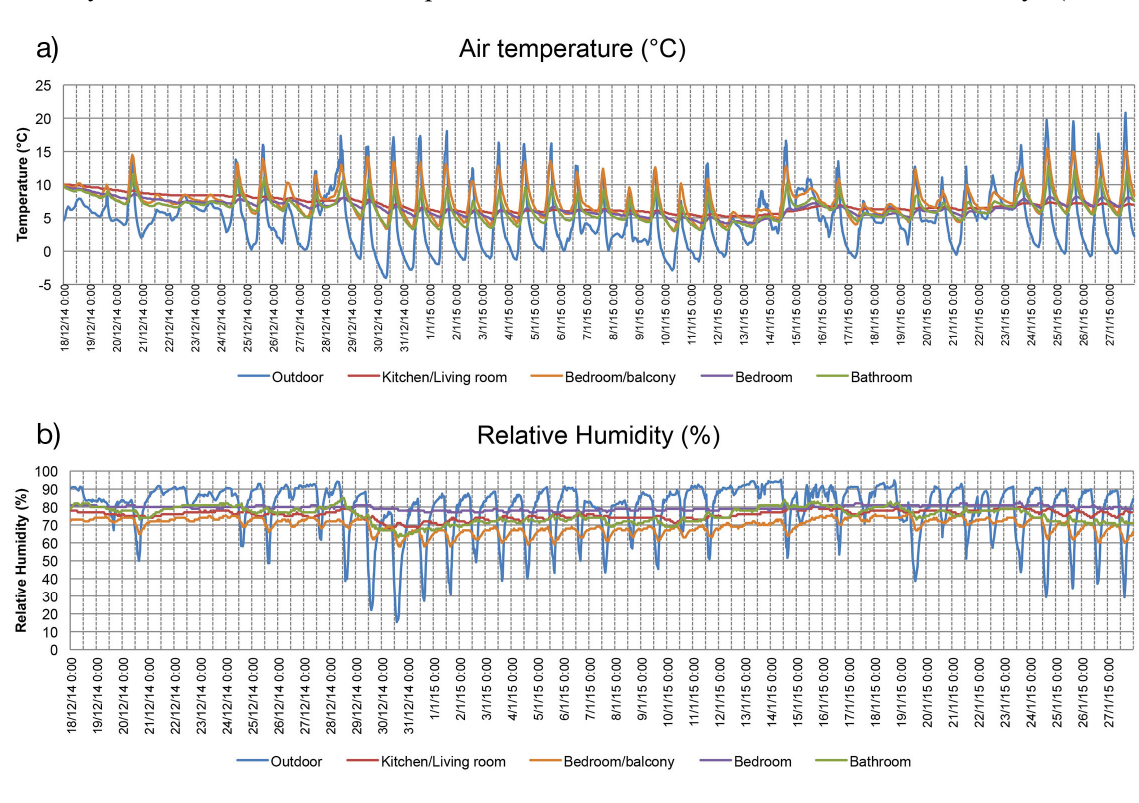
Figure 10. Case study 1 performance during winter season. ( a ) Indoor and outdoor air temperature profile; ( b ) Indoor and outdoor relative humidity profile. Table 2. Comparison of outdoors and indoors air temperature and relative humidity values in case study 1 during the winter